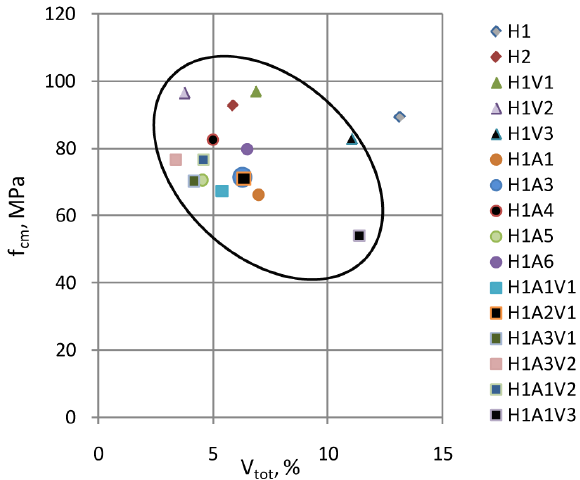
Fig. 5. The comparison of the research results of compressive strength and total porosity of